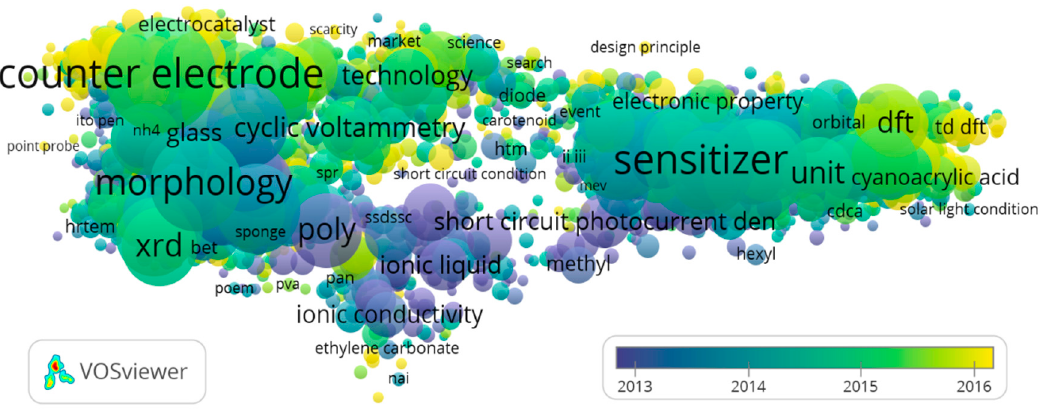
Figure 2. Terms from titles and abstracts of DSSC papers colored by novelty.